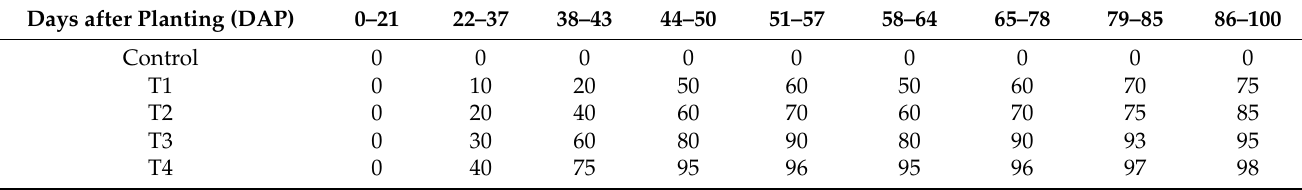
Table 1. Treatment details for the period of the first cut ryegrass ( Lolium perenne ); depletion level ( p ) as % of total available water — TAW-(C.I. Tibaitatá, 2012/2013). Days after Planting (DAP)